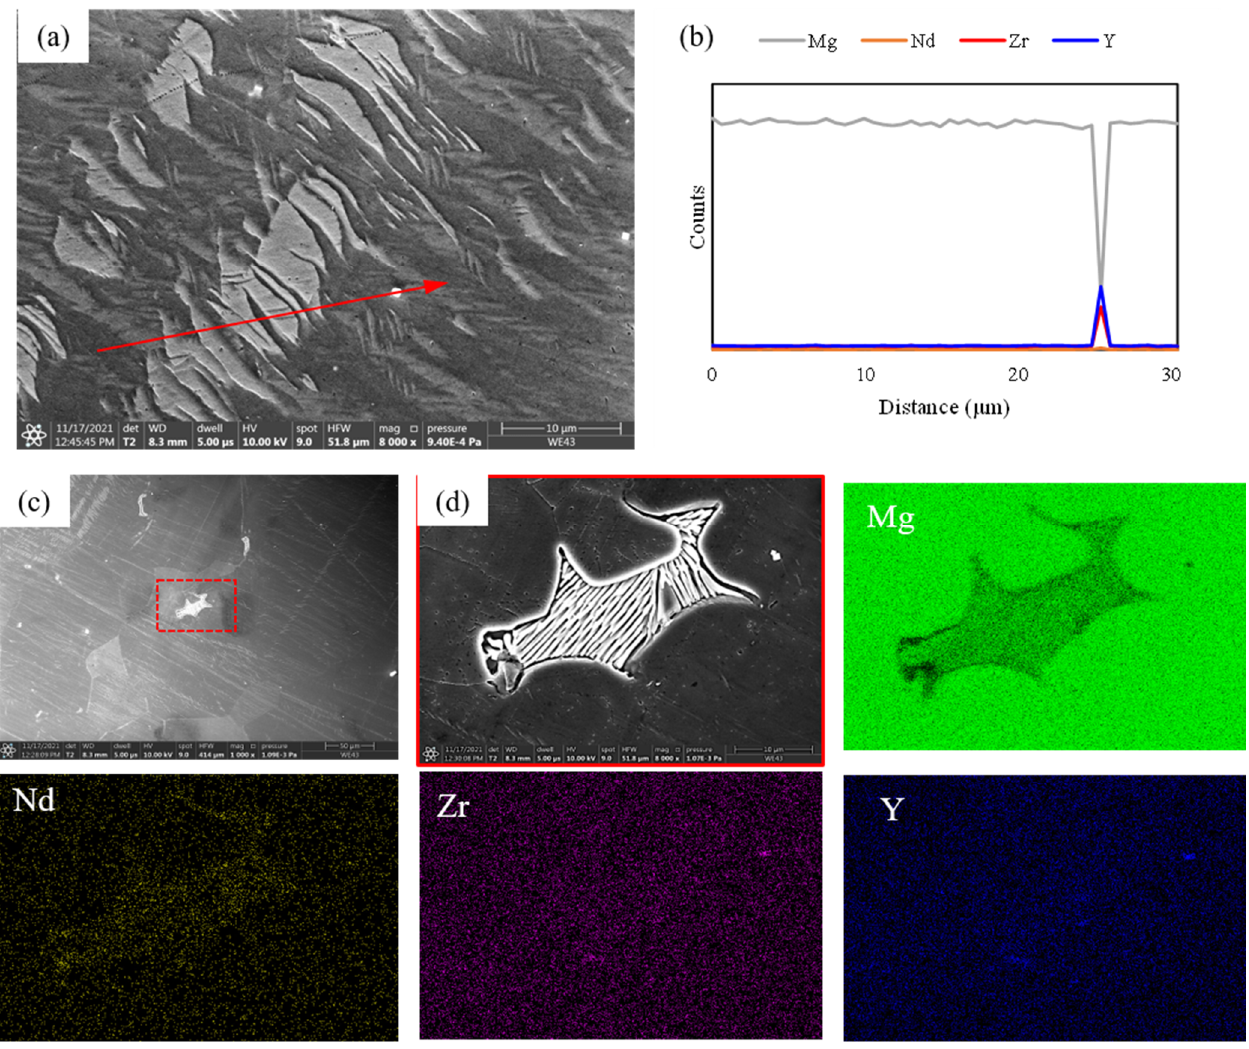
Figure 5. ( a ) SEM image of the α-Mg matrix in the core region and ( b ) elemental compositional analysis across line shown in ( a ). ( c ) Eutectic observed in core region and ( d ) EDS elemental maps of eutectic intermetallic in the core region.